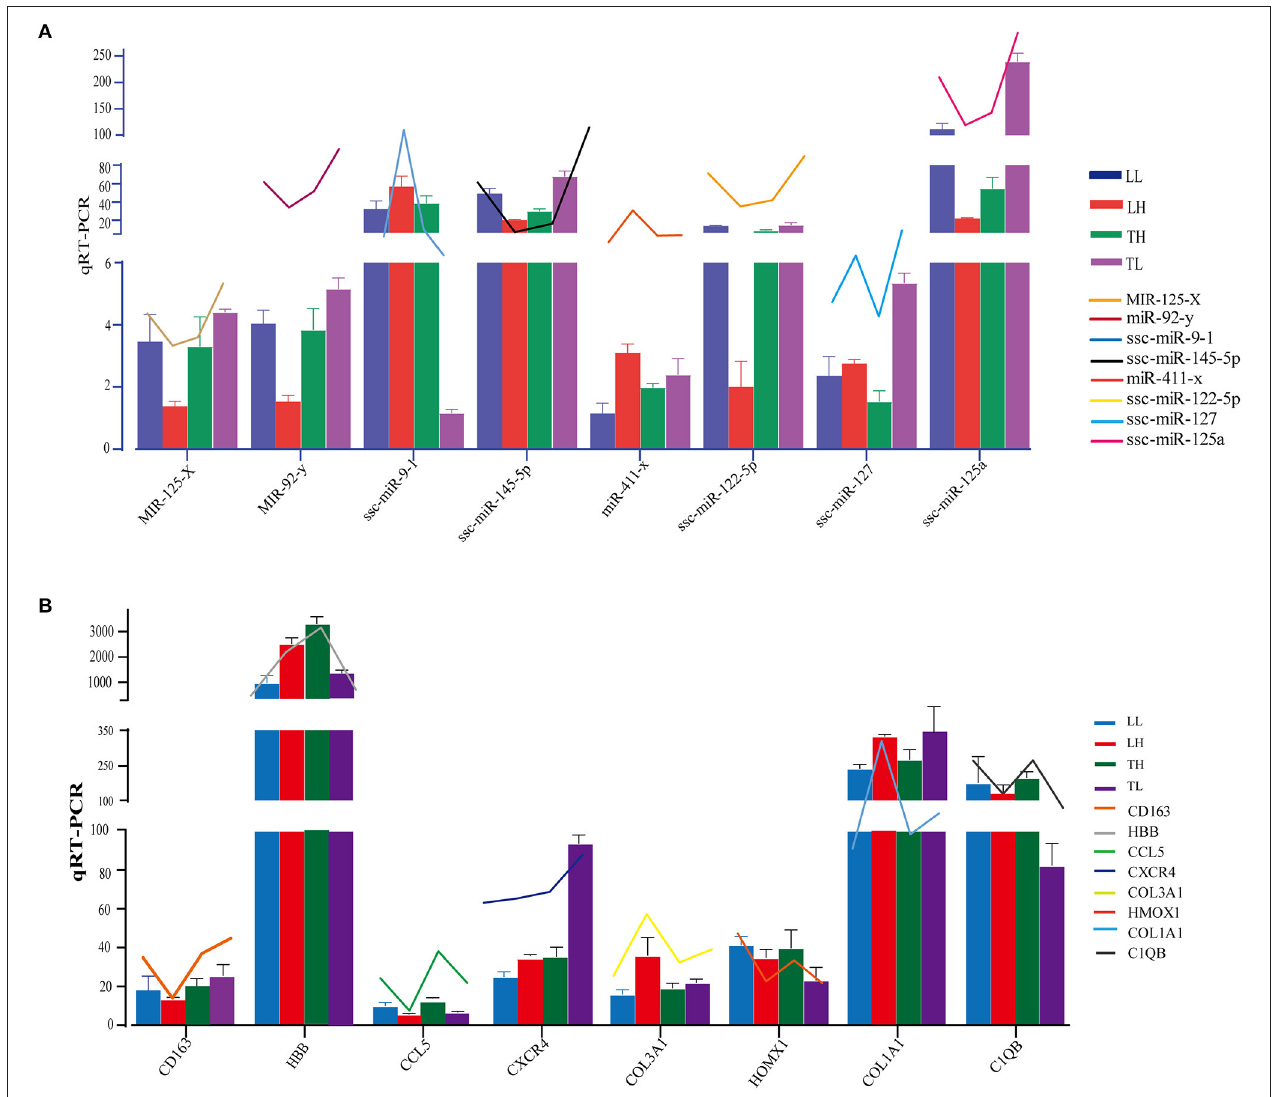
FIGURE 4 | Expression patterns of randomly selected DEmRNAs and DEmiRNAs. (A) Eight mRNA expression levels were confirmed by qRT-PCR in comparison to corresponding data detected in mRNA-Seq. GAPDH was used as control. (B) Eight miRNA expression levels were confirmed by qRT-PCR in comparison to corresponding data detected in mRNA-Seq. U6 was used as control. The broken line indicates the change in transcript level according to the FPKM value of mRNA-seq and miRNA-seq. Three biological replicates with three technical replicates each were used. The values represent the mean ± SE ( n =